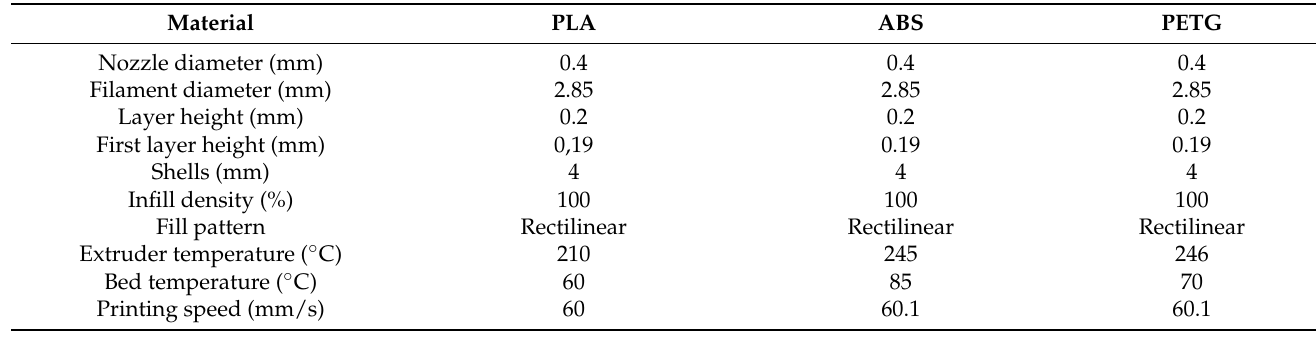
Table 2. Production stages of plastic gears.